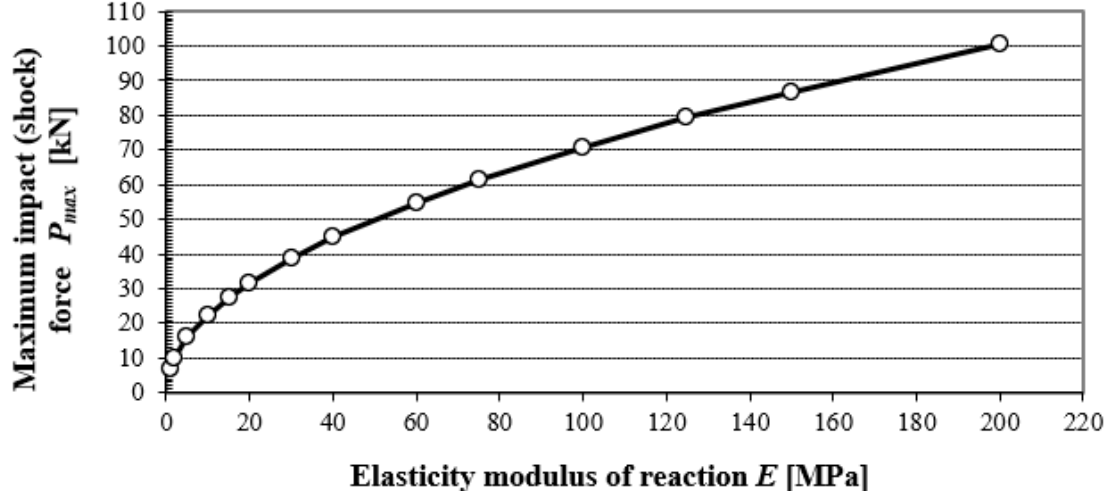
Figure 4. Dependency of maximum impact force on elasticity modulus of reaction of subgrade.